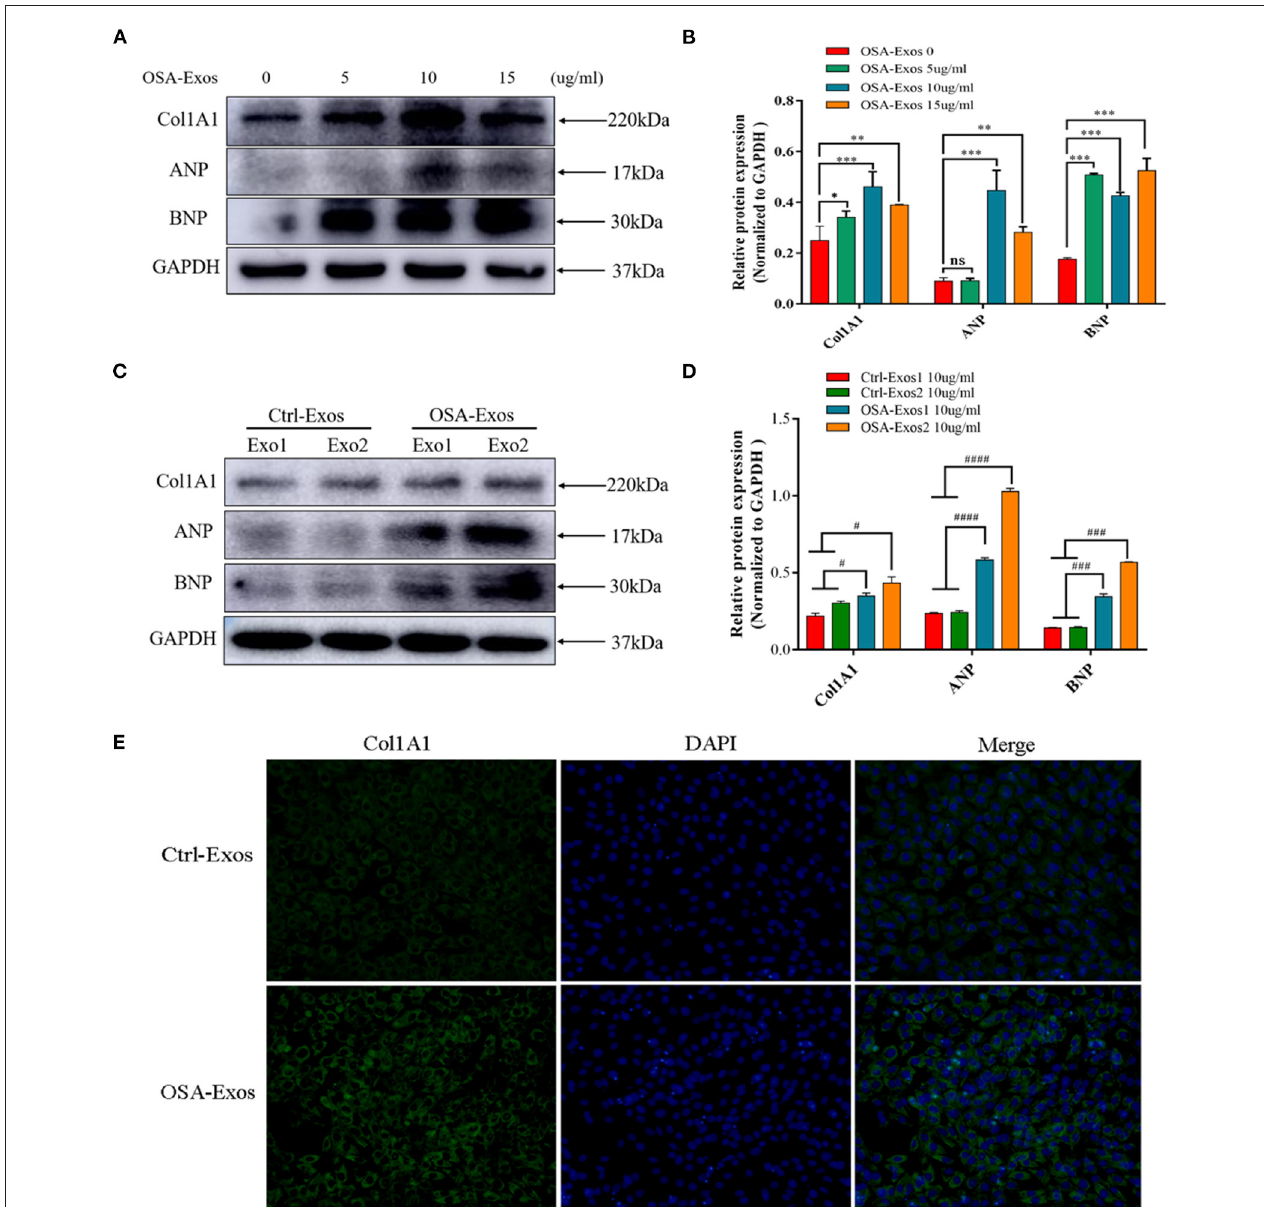
FIGURE 2 | Exosomes from OSA patients (OSA-Exos) increased the expression of Col1A1, ANP and BNP in H 9 C 2 cells. (A) Col1A1 and BNP protein expression was significantly increased in H 9 C 2 cells after treatment with 5, 10, and 15 µ g/ml exosomes from one OSA patient compared with the control (0 µ g/ml); ANP protein expression was significantly increased in H 9 C 2 cells after treatment with 10 and 15 µ g/ml exosomes compared with the control (0 µ g/ml). (B) Densitometric analyses of the Western blot presented in A. (C) Col1A1, ANP and BNP protein expression was significantly increased in H 9 C 2 cells treated with 10 µ g/ml OSA-Exos compared with exosomes from healthy controls (Ctrl-Exos) as assessed by Western blot. (D) Densitometric analyses of the Western blot presented in C. GAPDH served as the internal control. (E) H 9 C 2 cells were treated with 10 µ g/ml OSA-Exos and Ctrl-Exos. Col1A1 (green) expression was detected by immunofluorescence staining. The bars indicate the mean ± SD of three separate experiments. * p < 0.05, ** p < 0.01, *** p < 0.001 vs. OSA-Exos 0 group. # p < 0.05, ### p < 0.001, #### p < 0.0001 vs. Ctrl-Exos groups. ns, no